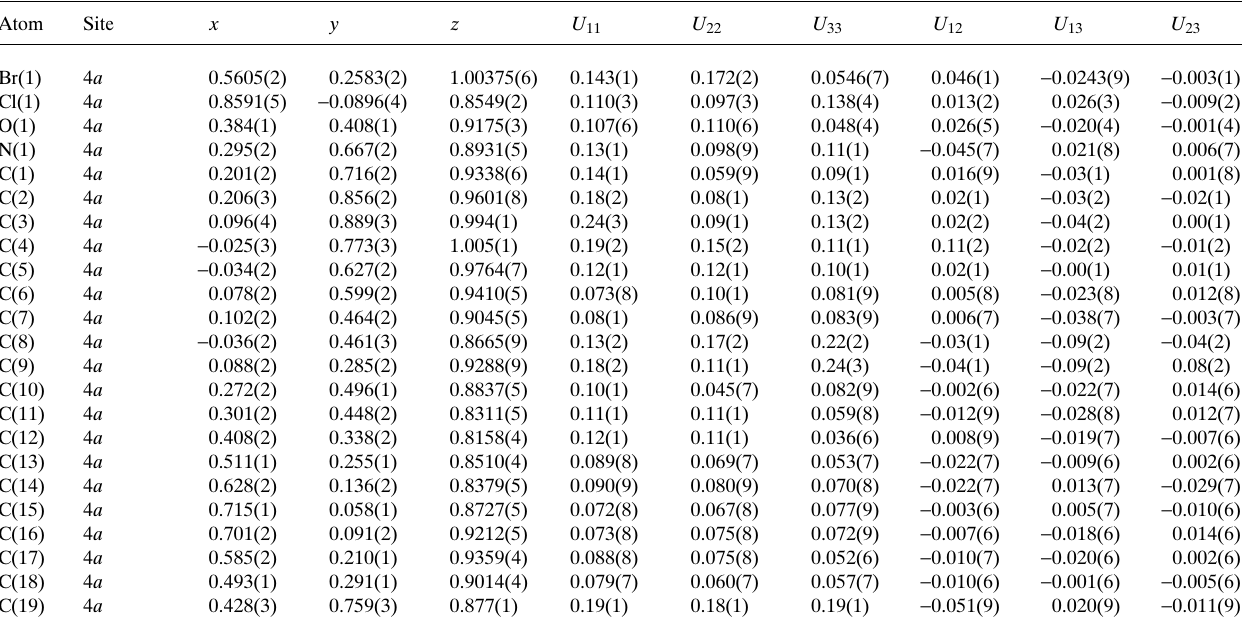
Table 3. Atomic coordinates and displacement parameters (in Å 2 )